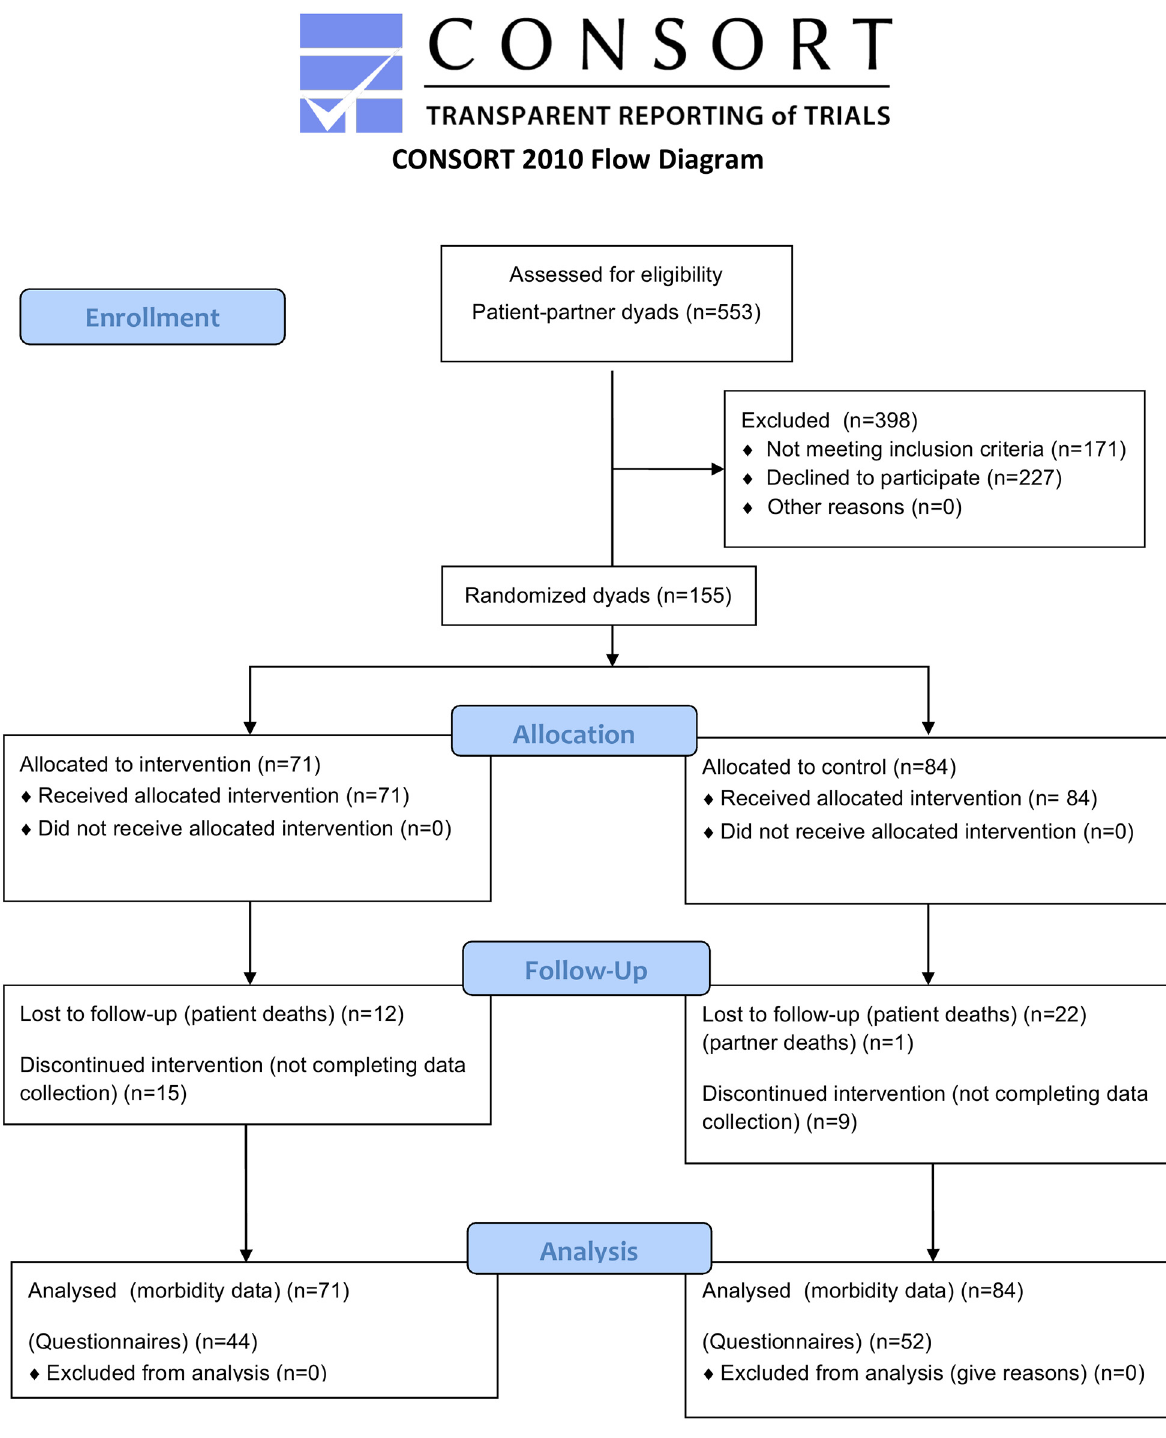
Fig 1. Flowchart for the participating dyad from enrolment until 24 months.